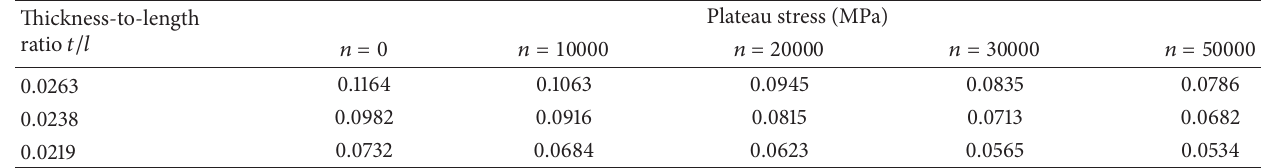
Table 2: Plateau stress of honeycomb paperboard after FD (23 ∘